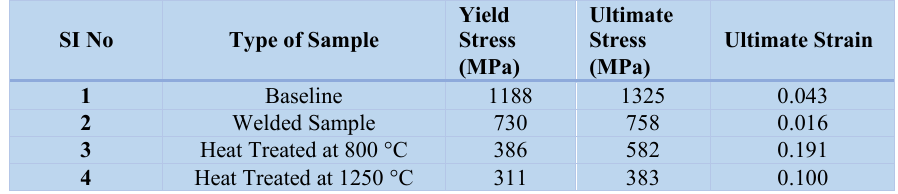
Table 2 : Material properties derived from the test data